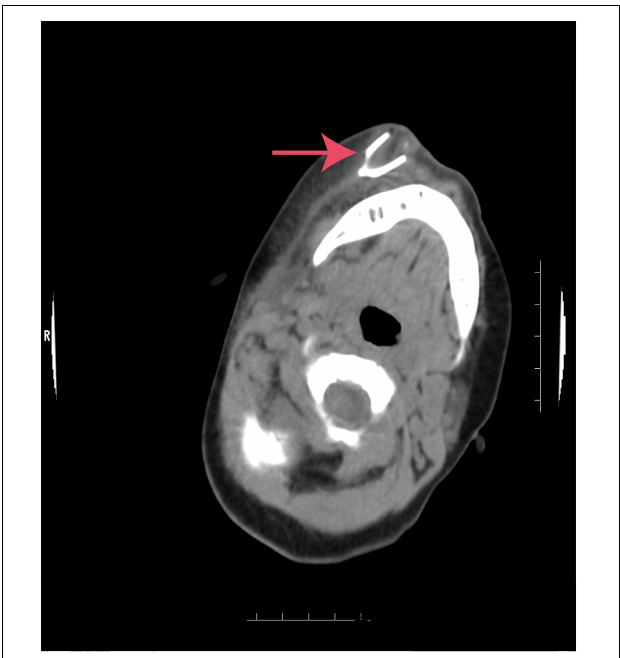
FIGURE 1 | Computerized tomography (CT) scan of the head and face. A short strips of “U” shaped high density structure (red arrow) due to foreign body in the right cheek.